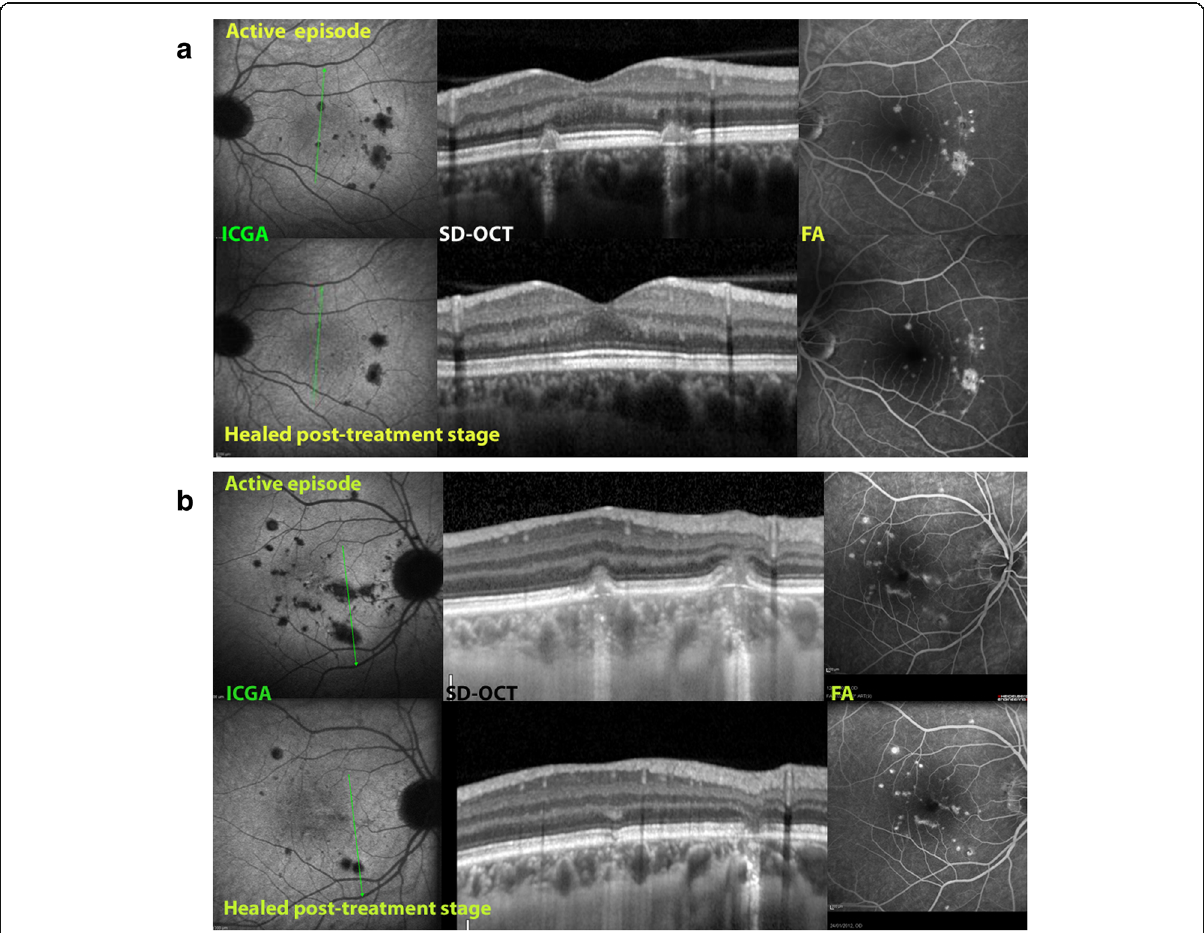
Fig. 11 Case of MFC during acute episode (top 3 images) and after treatment (bottom 3 images. b. Case of MFC during acute episode (top 3 images) and after treatment (bottom 3 images. Figures 11a & b: Spectralis - ICGA/FA/ and OCT images in two cases of MFC. During the active phase of the disease (top lines of pictures), OCT findings disclose the presence of two inflammatory lesions showing damaged and clumped photoreceptor outer segments; RPE layer appears interrupted at its peak with, in the second case (11b), material infiltrating the subretinal space without the involvement of the inner retina. In the quiescent phase (bottom lines of pictures), OCT shows the resolution of the agglomerated material. It is also interesting to note that the FA images (right frames) do not permit to distinguish the active phase versus the quiescent phase of the